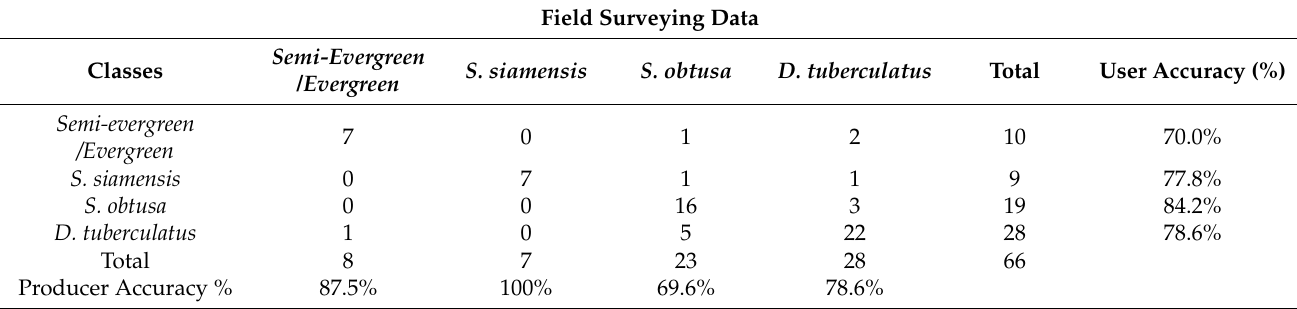
Table 3. Accuracy assessment of the proposed